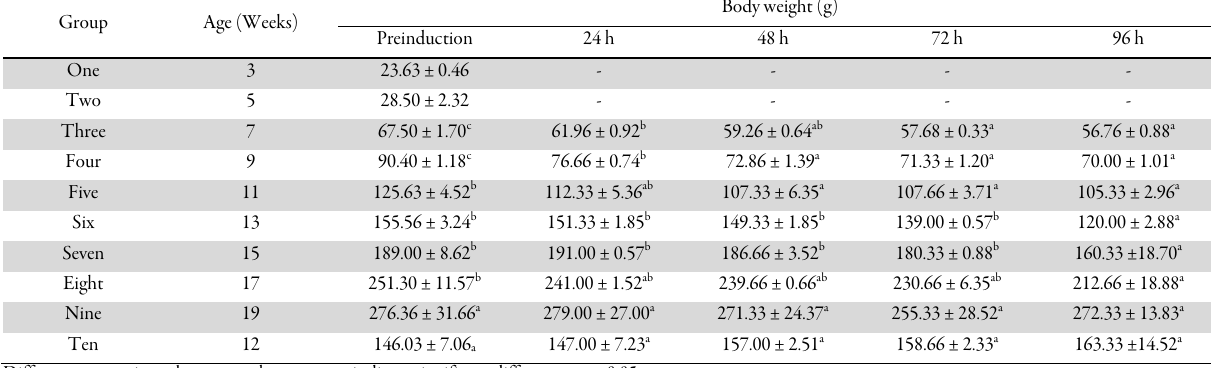
Table 3. Body weight of alloxan-induced diabetic rats of varying ages monitored for 96 h Group